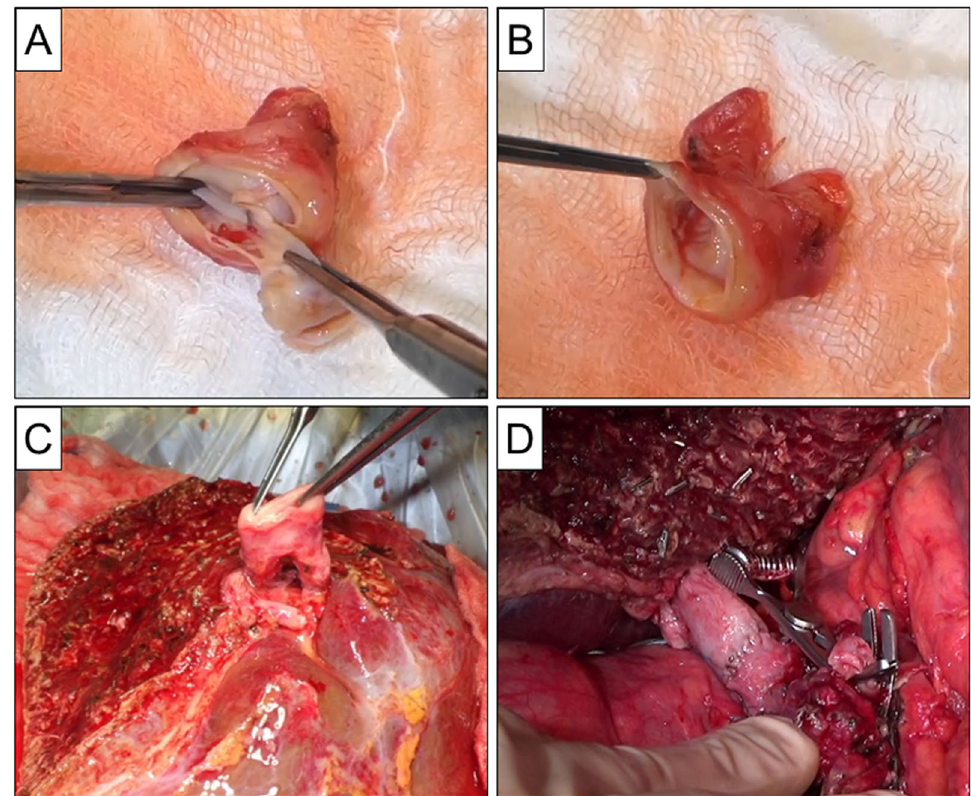
Fig. 2 Autologous portal Y-graft interposition after thrombectomy. A Portal venous thrombus extending from the main portal vein (PV) to the right PV branch of resected portal Y-graft was easily removed on the back table. B Portal Y-graft after removal of thrombosis. There was no damage to the inner surface of portal Y-graft. C The right and left limbs of the portal Y-graft were anastomosed to the anterior and posterior portal branches of the right liver graft on the back table. D The main PV of the Y-graft was anastomosed to the remnant main PV of the